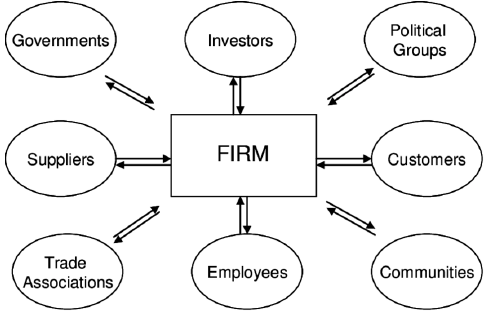
Figure 5. The stakeholder model (Donaldson and Preston 1995).